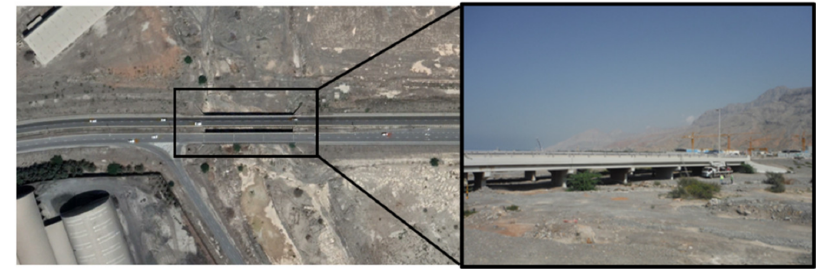
Figure 12. Ghalilah bridge.